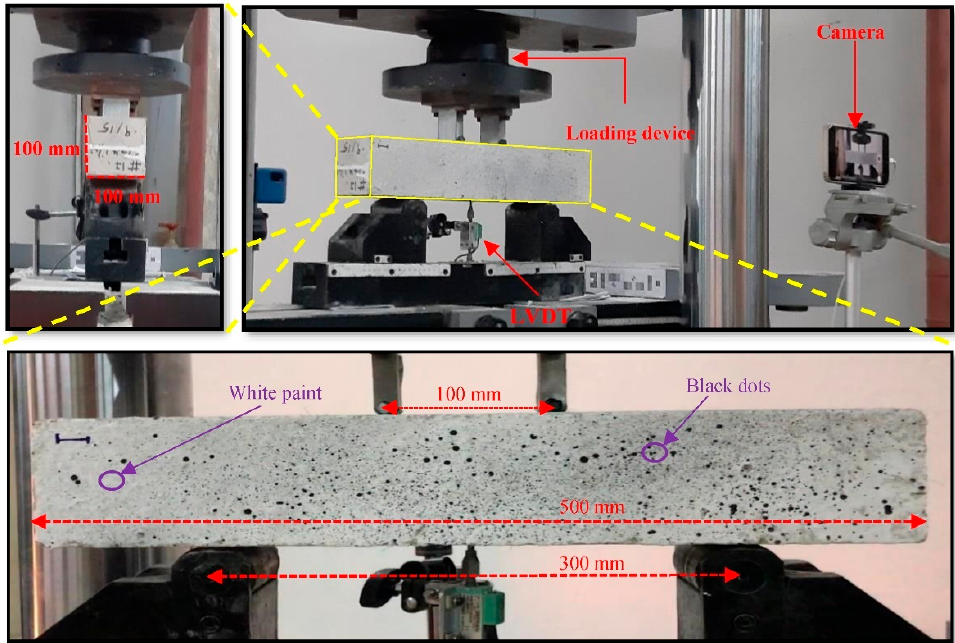
Figure 2. Four-point bending test setup for flexural strength determination and crack evolution assessment through the DIC technique.